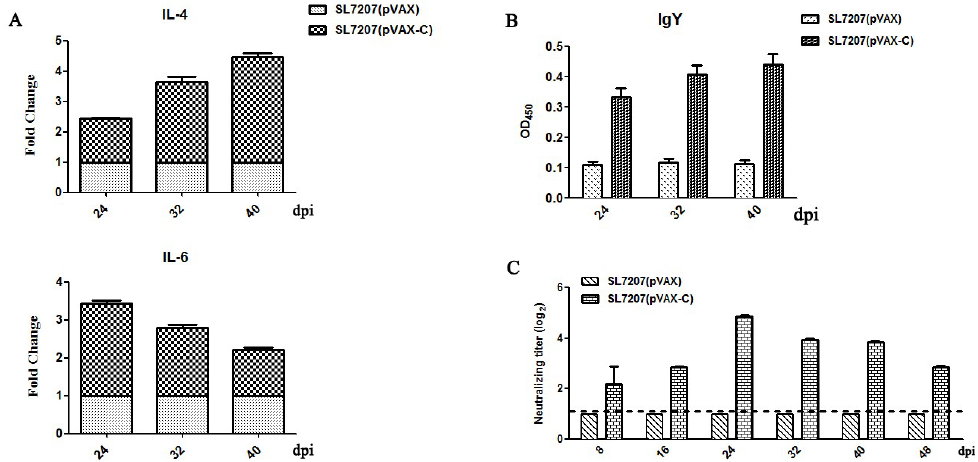
Figure 3. Immune responses stimulated by the vaccine. ( A ) Expression of IL-4 and IL-6 was measured by quantitative real-time polymerase chain reaction (RT-PCR) to evaluate the cellular immune responses. Data from RT-PCR was analyzed using 2 −ΔΔ C t method. The expression level of IL-4 and IL-6 in the SL7207 (pVAX-C) vaccinated group was presented as changed fold reference to those in the SL7207 (pVAX) group. Data are shown as the mean ± standard deviations ( n = 3 of each time point); ( B ) The specific antibody IgY in the serum against the DTMUV capsid protein was detected by using indirect ELISA. The serum samples were incubated with the capsid proteins and detected by using the horseradish peroxidase conjugated goat anti-bird IgY. OD 450 value of each well was measured. The titers of the specific antibody were presented as the means ± standard deviations ( n = 3 of each time point); ( C ) Neutralizing antibodies against DTMUV in the serum was detected by neutralizing assay. The titers of neutralizing antibodies against DTMUV were detected and presented as the log 2 changed folds (Y-axis) reference to the negative control group SL7207 (pVAX). Data are shown as the means ± standard deviations ( n = 3 of each time point). The dash line indicates the lowest threshold value for positive reaction in the neutralizing assay. All data were graphed by GraphPad Prism v5.0 (La Jolla, CA,